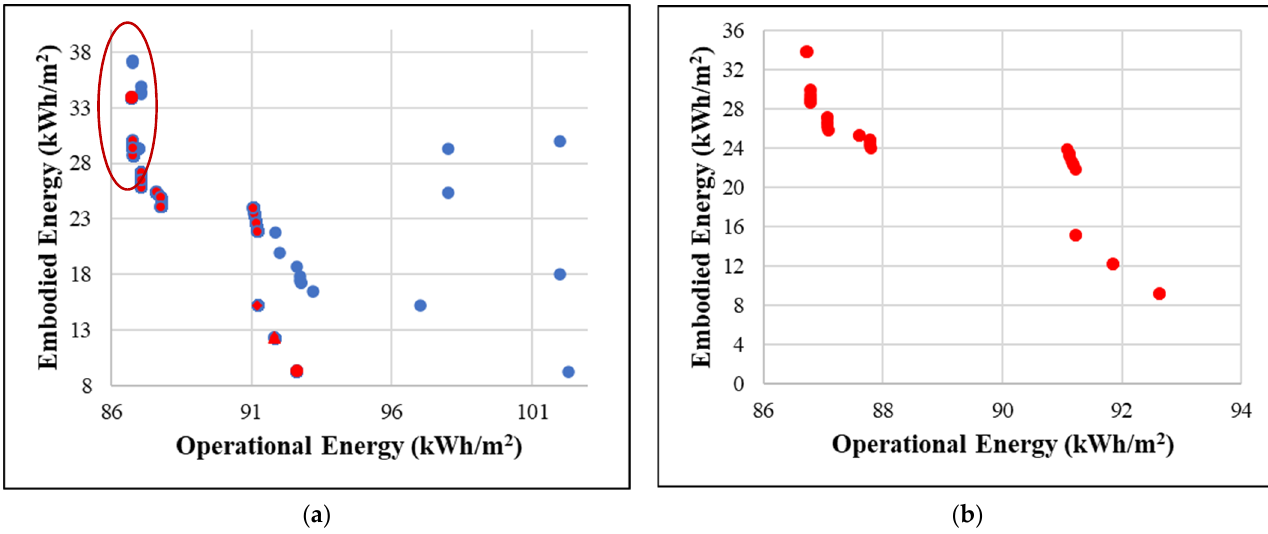
Figure 10. Scatterplot of operational energy use against embodied energy use (Accra, Ghana). ( a ) Entire solution space, ( b ) Pareto optimal solutions.